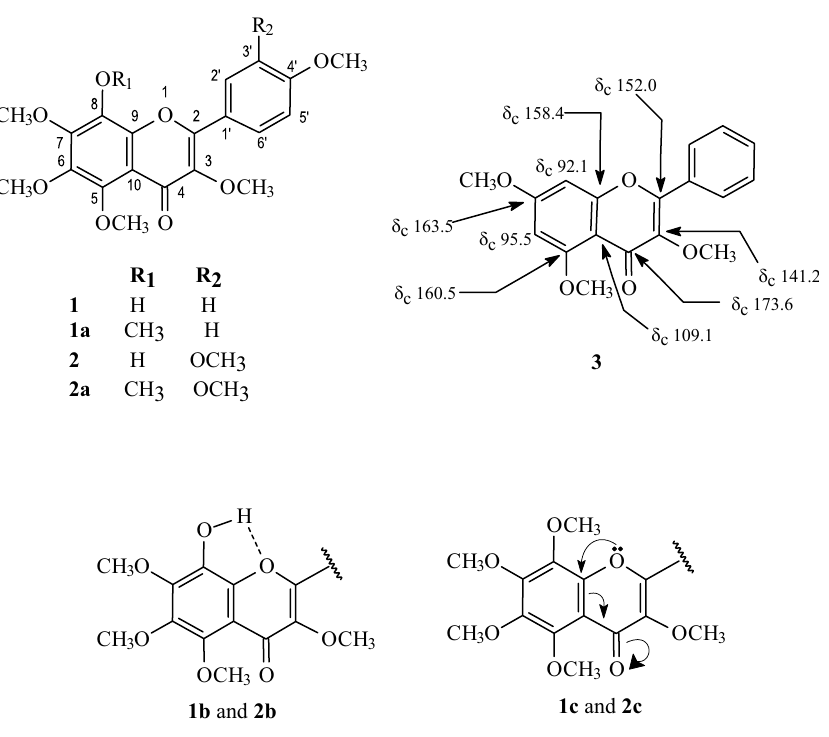
Fig. 1 – Structure of the new 8-hydroxyflavonols 1 and 2 , derivatives 1a and 2a and model flavonol 3 .